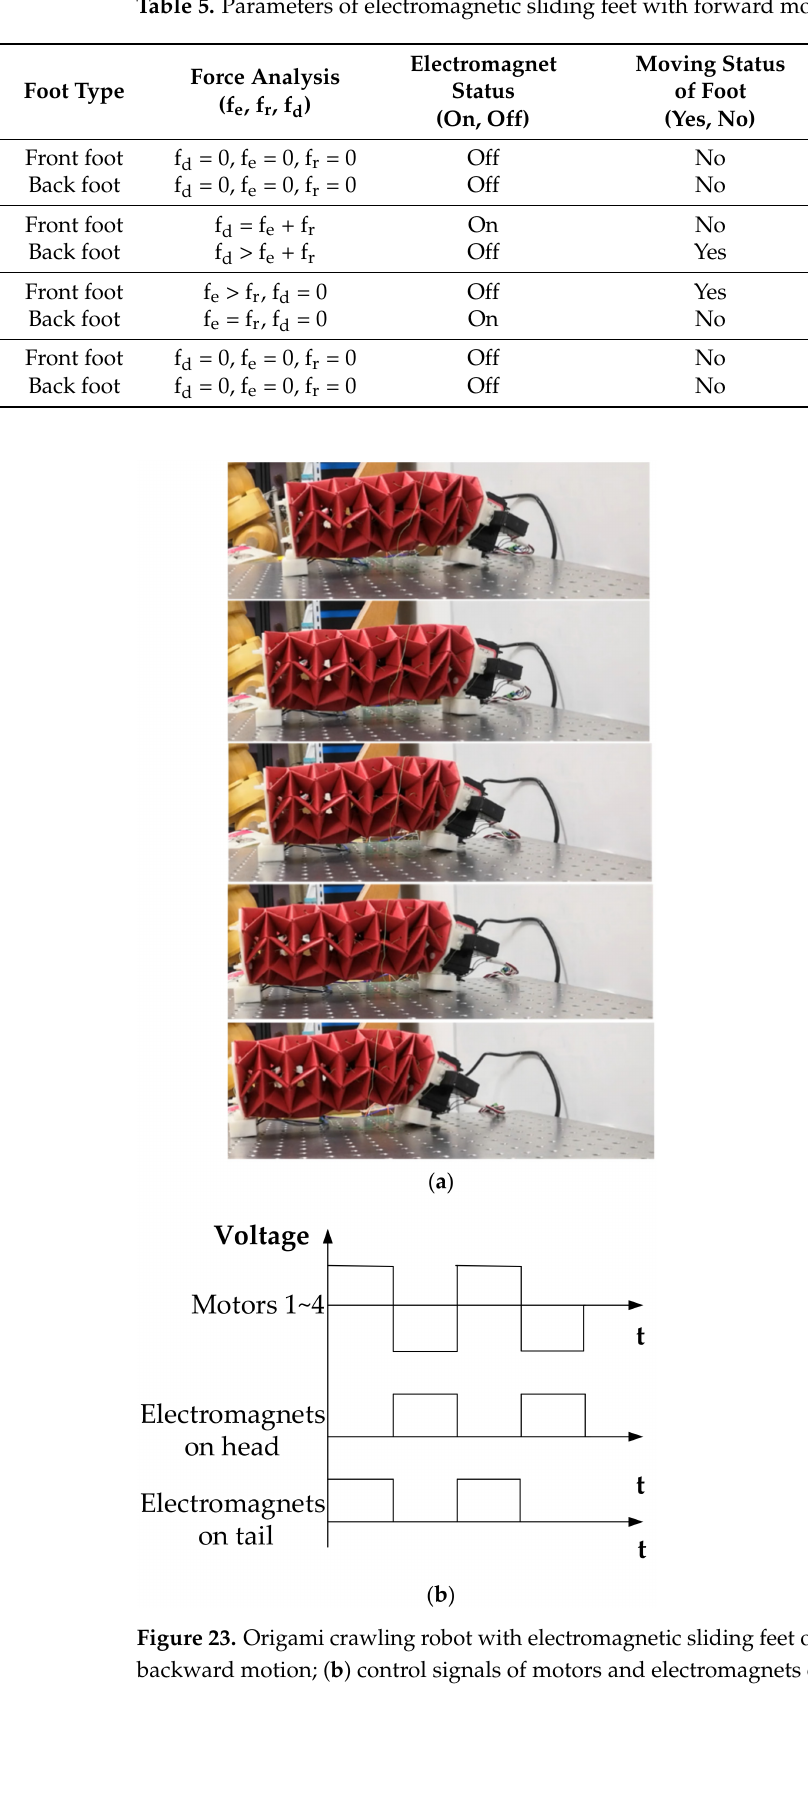
Table 5. Parameters of electromagnetic sliding feet with forward motion in one working cycle.